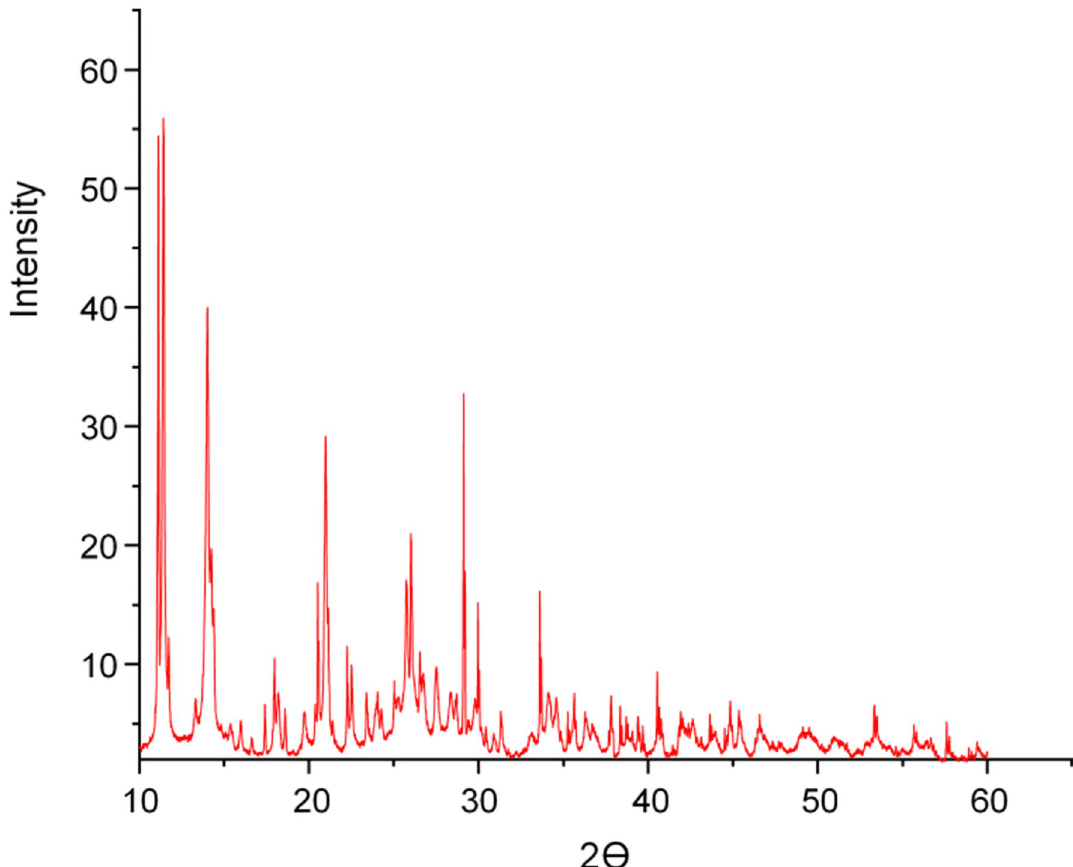
Fig 5. X-ray powder diffraction patterns of the [(UO 2 )(OAc) 2 (MP)]